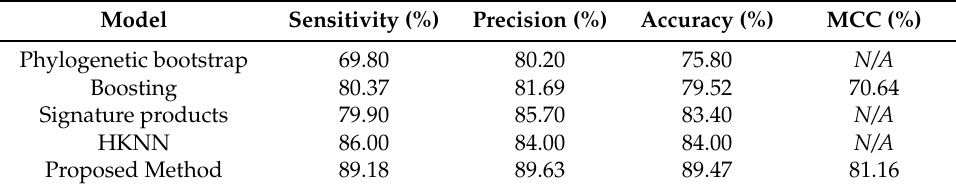
Table 5. Comparison of other methods on the H. pylori